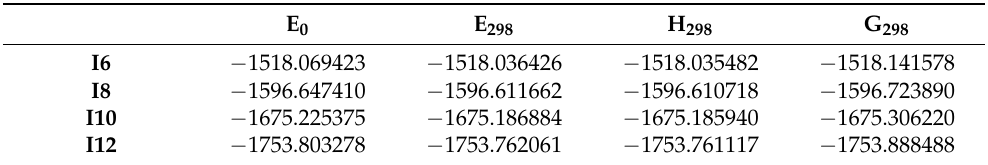
Figure 4. The optimized geometries of the studied compounds I n . Table 2. The energetics and thermodynamical parameters (in Hartree) of the optimized structures at the B3LYP/6-31+G(d,p) level of theory.